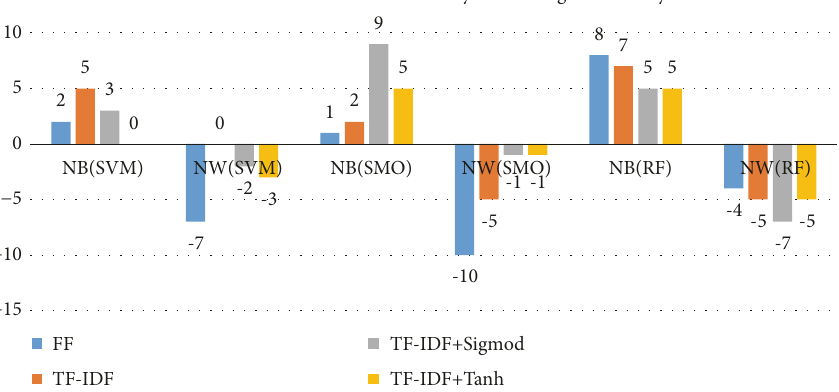
Figure 3: Best and worst number of activity concerning on accuracy concerning on “tulum2009”.